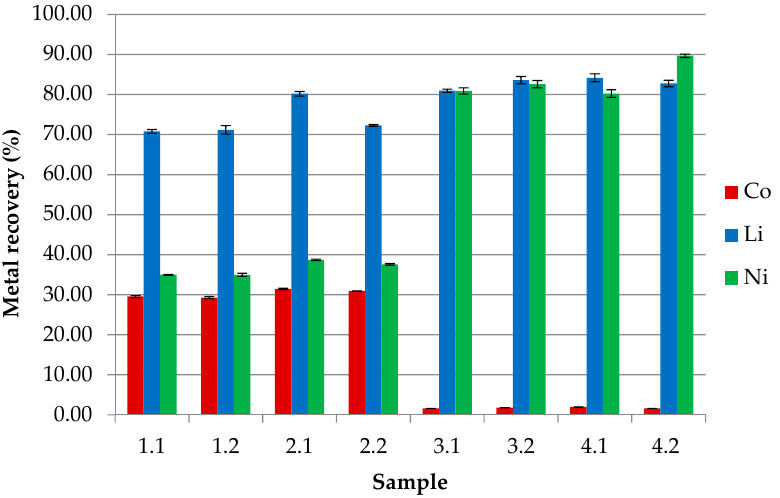
Figure 2. Recovery degrees for Co, Li, and Ni from solutions obtained by leaching with 1.5 M sulfuric acid with or without the presence of 3 mL perhydrol.